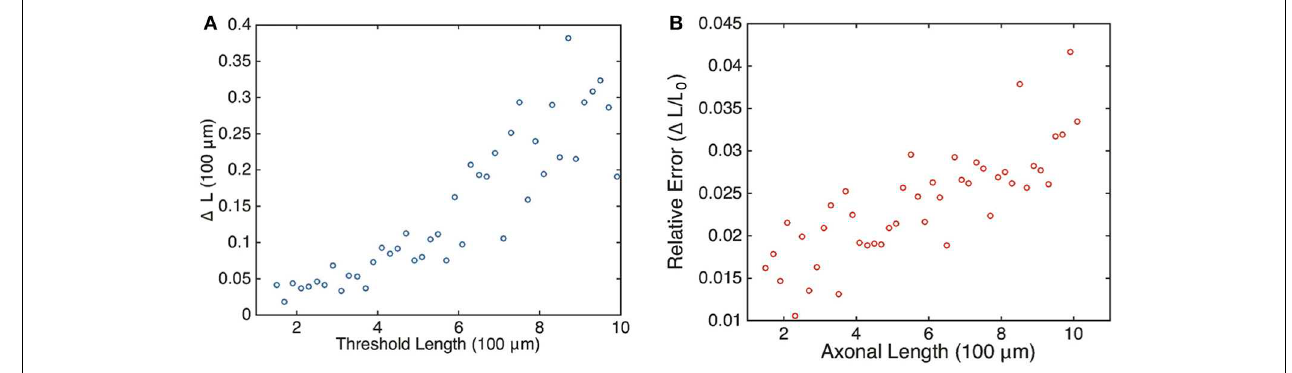
mean protein outputs and determining what length that protein value corresponded to according to the curve shown in Figure 4 . 1 L was determined by looking at what axonal length each individual mean protein output realization corresponded to according to Equation (4) and then finding the variance in this set of